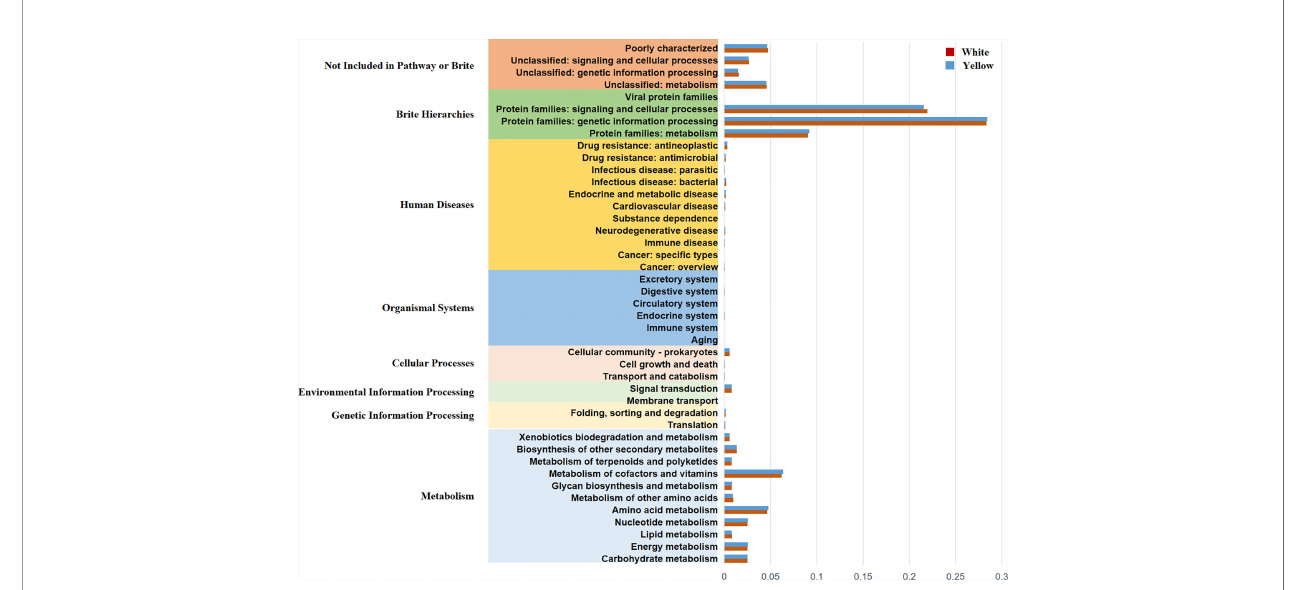
FIGURE 6 | Histogram of functional prediction for different groups of